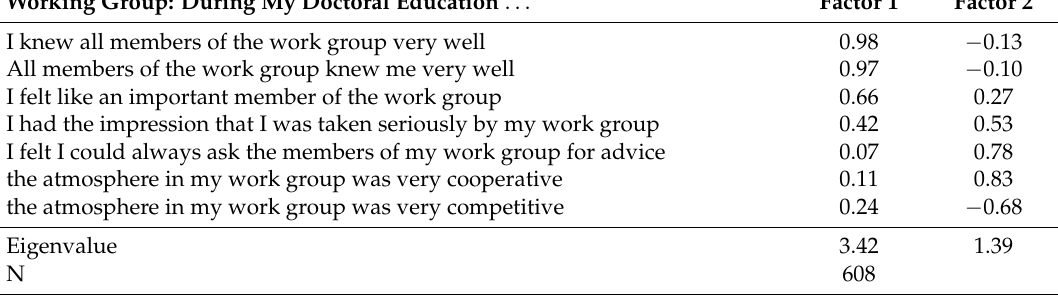
Table A1. Working Group and Scientific Community Integration. Factor Loadings of CatPCA. Working Group: During My Doctoral Education . . .